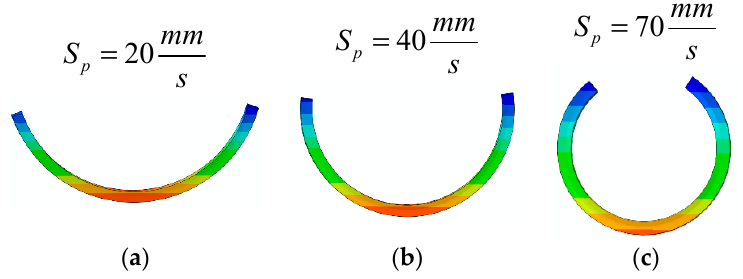
Figure 8. The FE Abaqus simulation of the self-bending beams illustrated in Figure 7. Table 4. Geometric parameters of the beams printed with di ff erent speeds after the heating–cooling process.